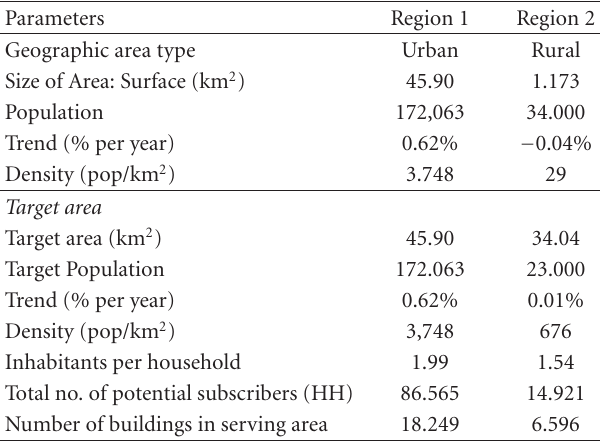
Table 2: Territorial and demographic scenarios.